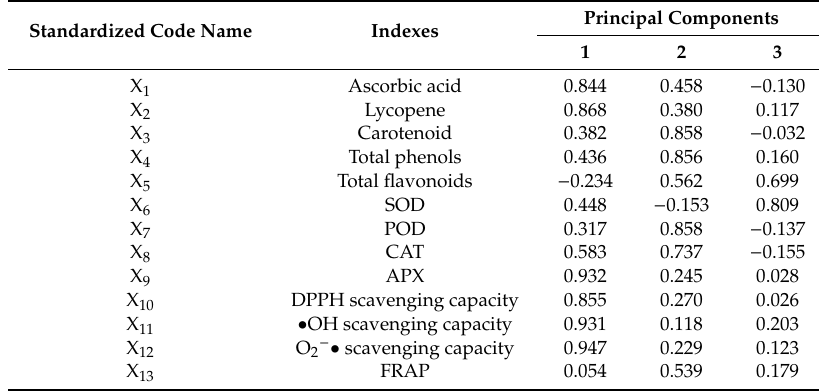
Table 2. Rotated component matrix of the principle component